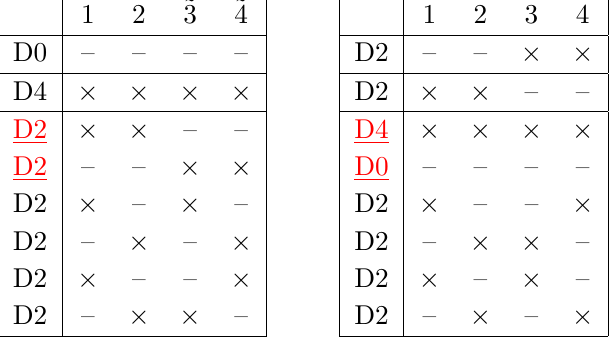
Table 2 . In the left table we display the branes present in a general solution of (2.5). To the right is the resulting branes after reversing the T-dualities depicted in table 1, e.g. the T-brane frame. The branes colored in red and underlined are not present in a T-brane